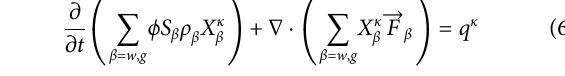
FIGURE 4 | Layers of the model.